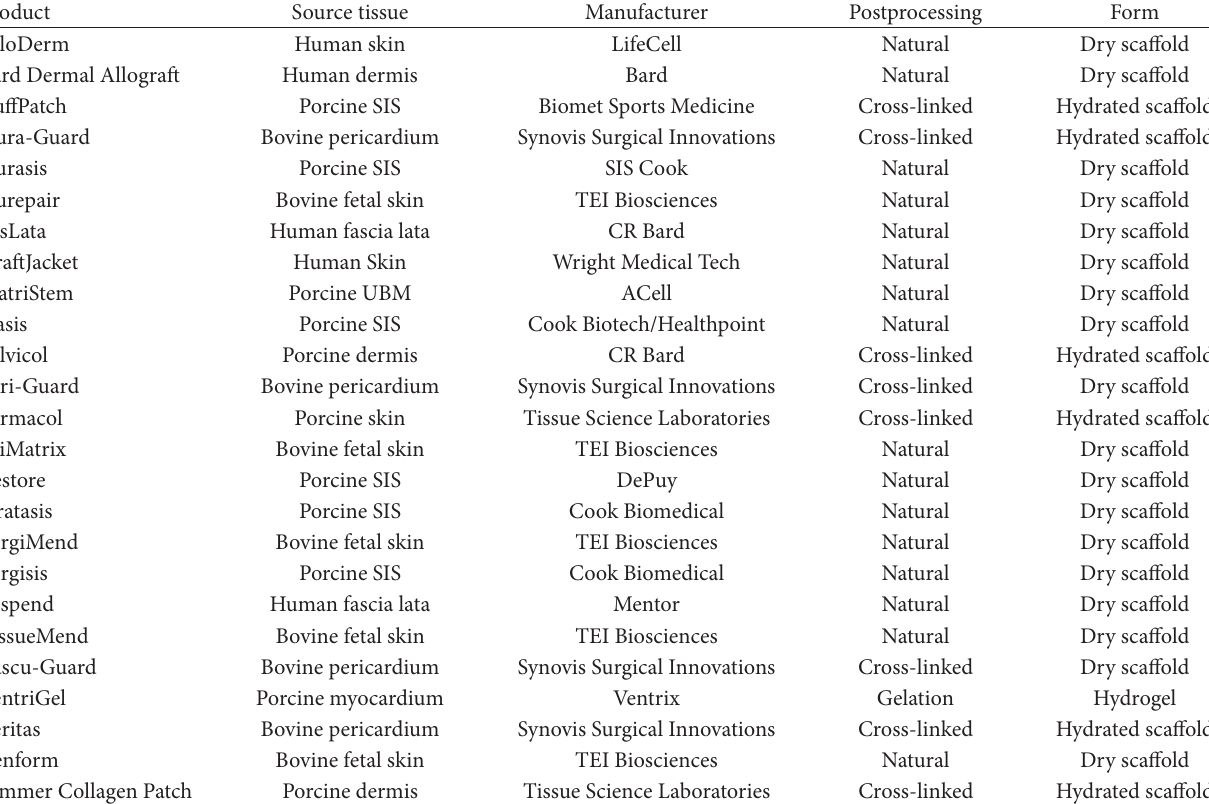
Table 2: Commercially available ECM-derived products for surgical applications.